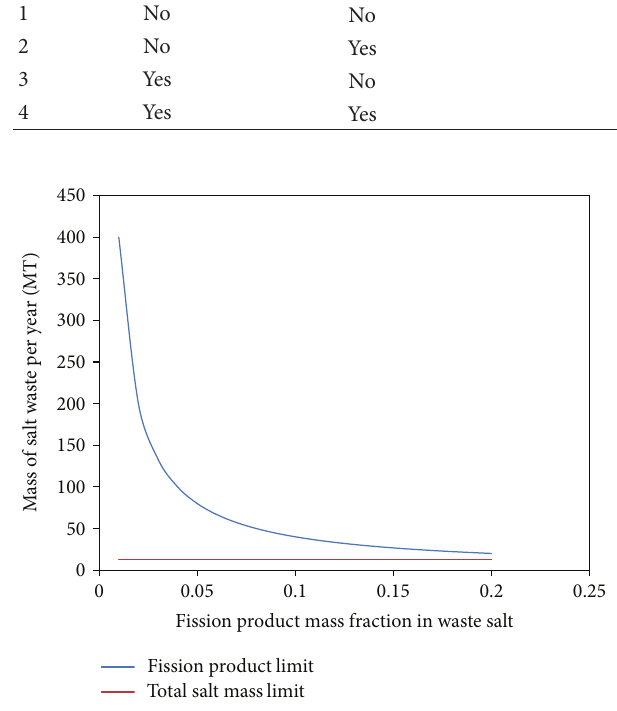
Figure 2: Estimated ER salt waste mass per year for a 100MT/year used metal fuel pyroprocessing facility considering cases where the ER is fission product limited or total salt mass limited and only salt throw-away is pursued.